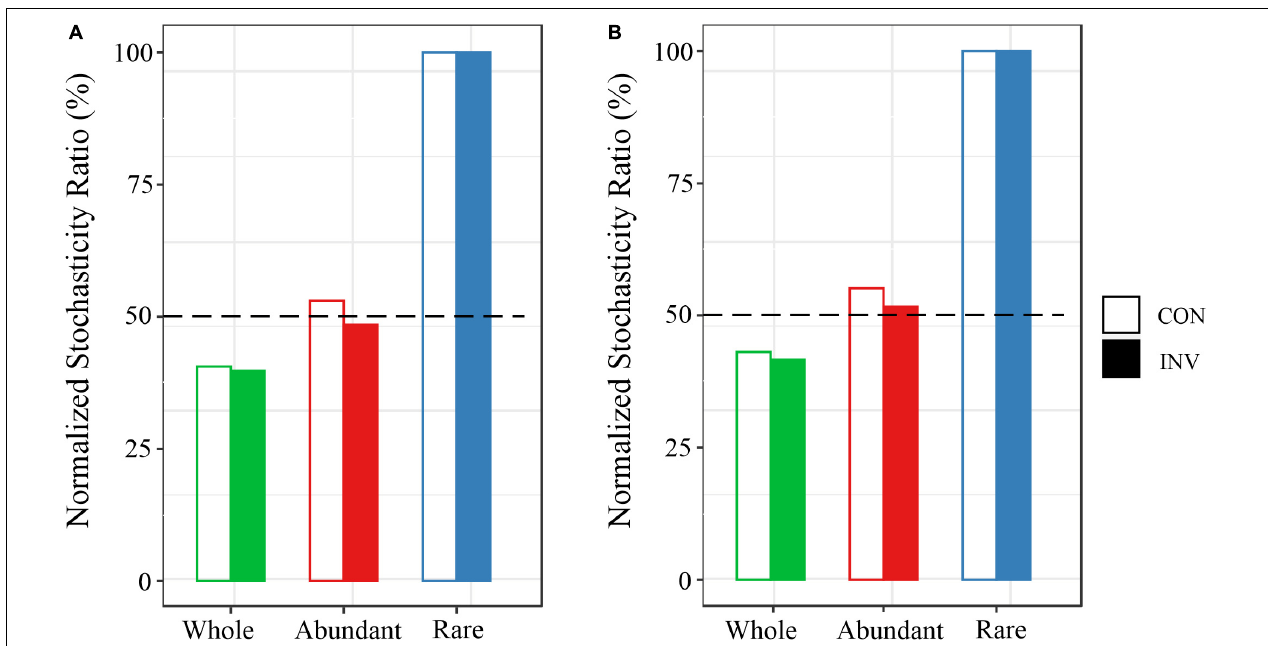
FIGURE 7 | The ecological stochasticity in the assembly of the potentially pathogenic bacterial community evaluated based on the normalized stochasticity ratio (NST) based on the Bray–Curtis indexes. (A) normalized stochasticity ratio of B sediment (B) normalized stochasticity ratio of P sediment.